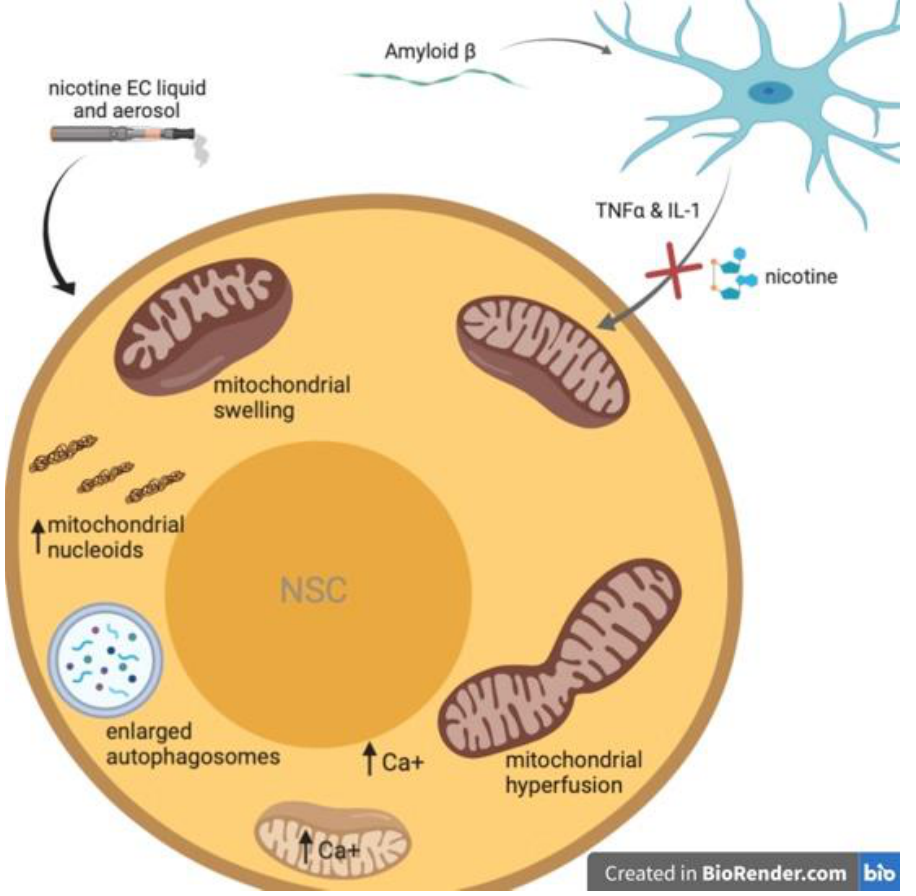
Figure 2. Summary of described effects of nicotine e-cigarettes (EC) liquid and aerosols on NSC mitochondria. EC treatments led to altered mitochondrial membrane potential (MMP), induced aggregation of mitochondrial nucleoids and mitochondrial DNA, and induced calcium influx leading to plasma membrane retraction and intracellular calcium overload.